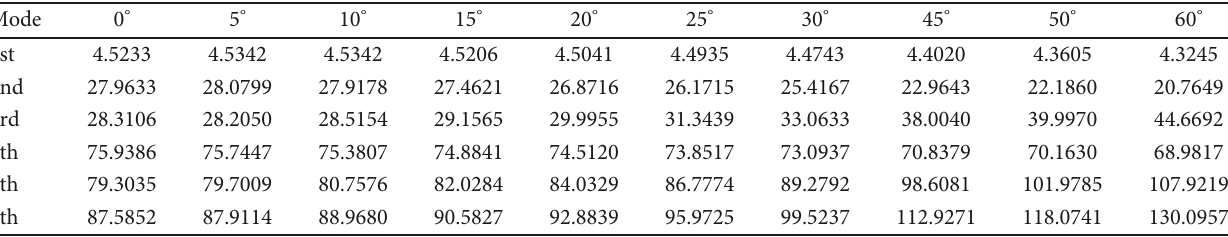
Table 6: Nondimensional frequency parameters for the fi rst six modes of FG sandwich blade with varying twist angle ( l = 3 , h = 20 , n = 2 , and = 1/2 h l